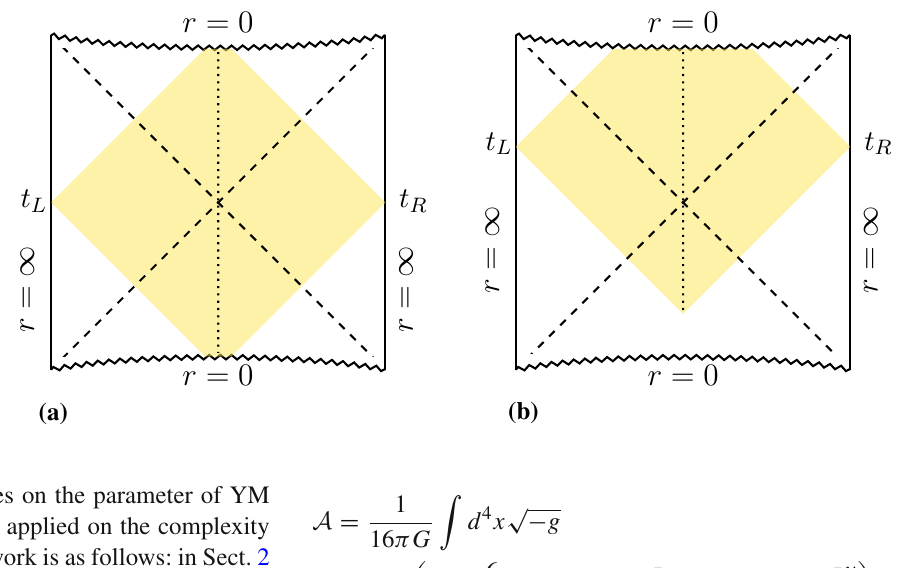
Fig. 1 Penrose diagram for a neutral two sided black hole and WDW patch in a initial and b late time